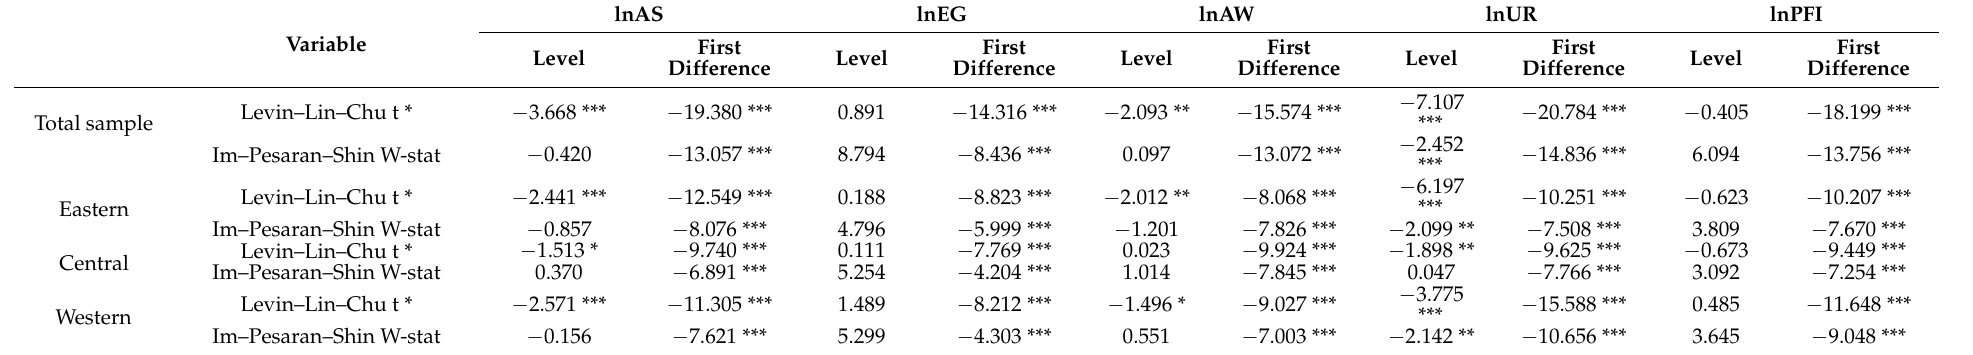
Table 2. Results of panel unit root test.